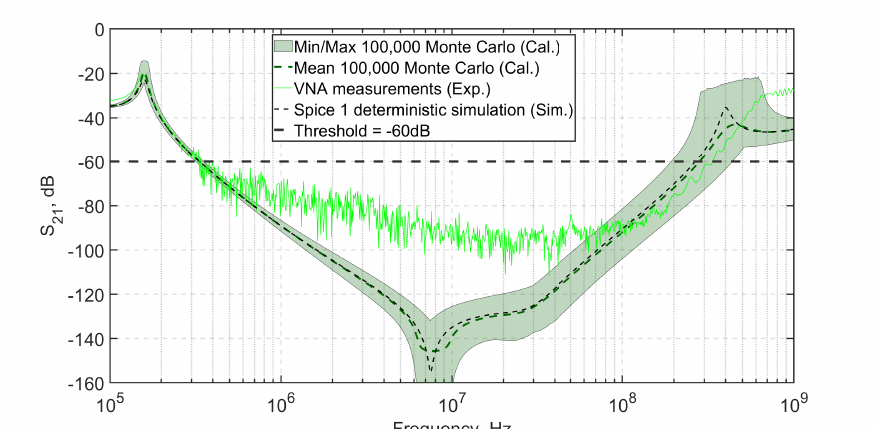
Figure 12. Filtering performances (statistics) from Test case #1/Channel #4 including: VNA measure- ments, simulations (Spice), MC calculations (analytical